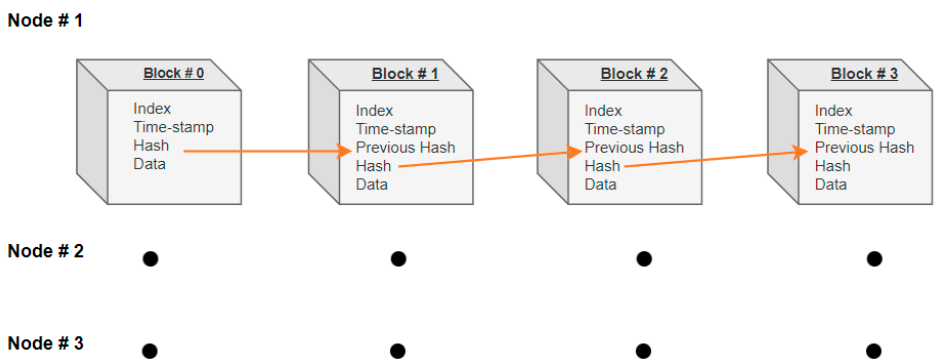
Figure 5. Example of Blockchain Blocks.